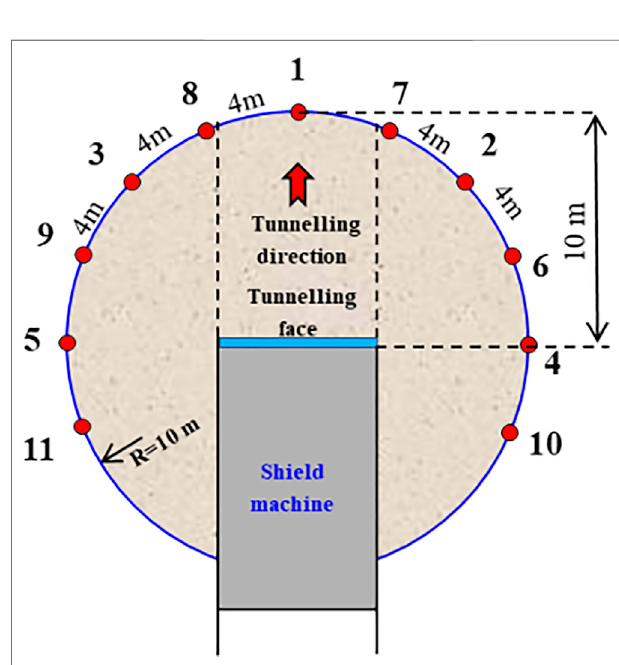
FIGURE 10 | Arrangement of detecting drilling holes for the limestone section of R3 Metro Line.